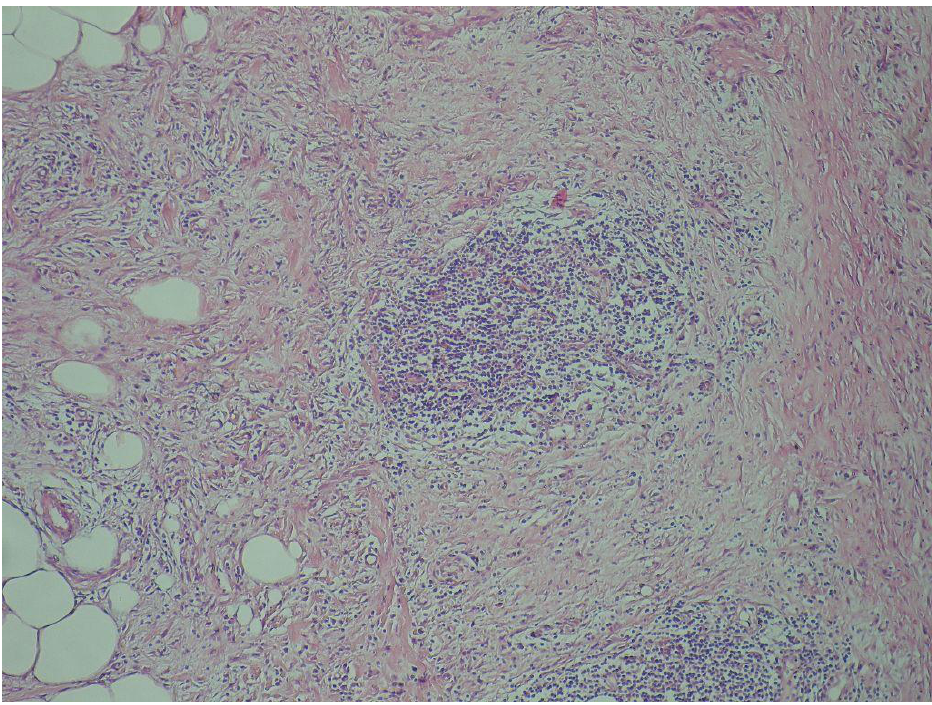
FIGURE 3 . Dense fibrosis, numerous plasma cells, eosinophils, histiocytes, and lymphoid aggregates were detected in the deeper wall of urinary bladder (H&E,  40).